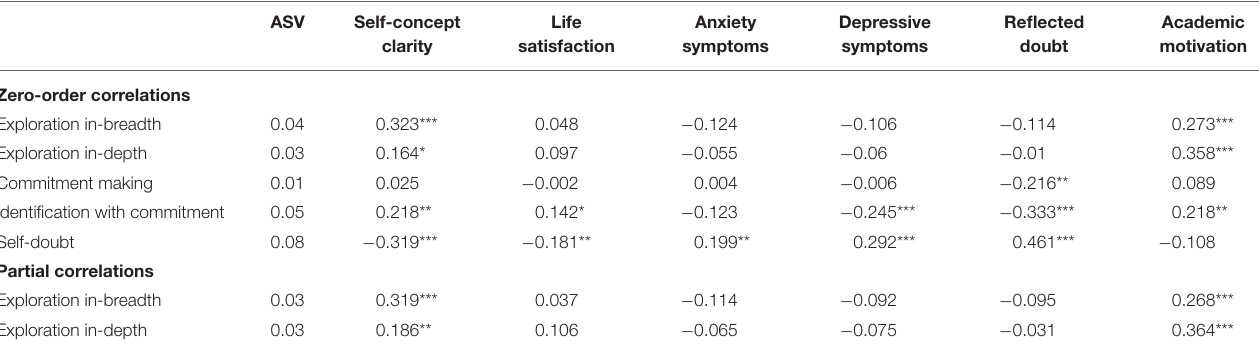
TABLE 2 | Zero-order and partial correlation testing the convergent validity of the pre-transition EIPS.